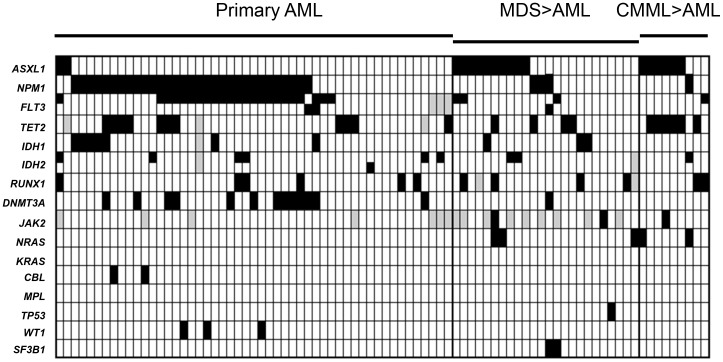
Concurrence of mutations in 16 genes analyzed in CN-AML samples.Columns show results for each of the 84 analysed cases. Solid boxes indicate mutated cases. Grey boxes mark unavailable data. FLT3-ITD mutations are indicated with top-half solid boxes and FLT3-TKD with bottom-half solid boxes. Similarly, IDH2-R140Q mutations are shown with top-half solid boxes and IDH2-R172K with bottom-half solid boxes.